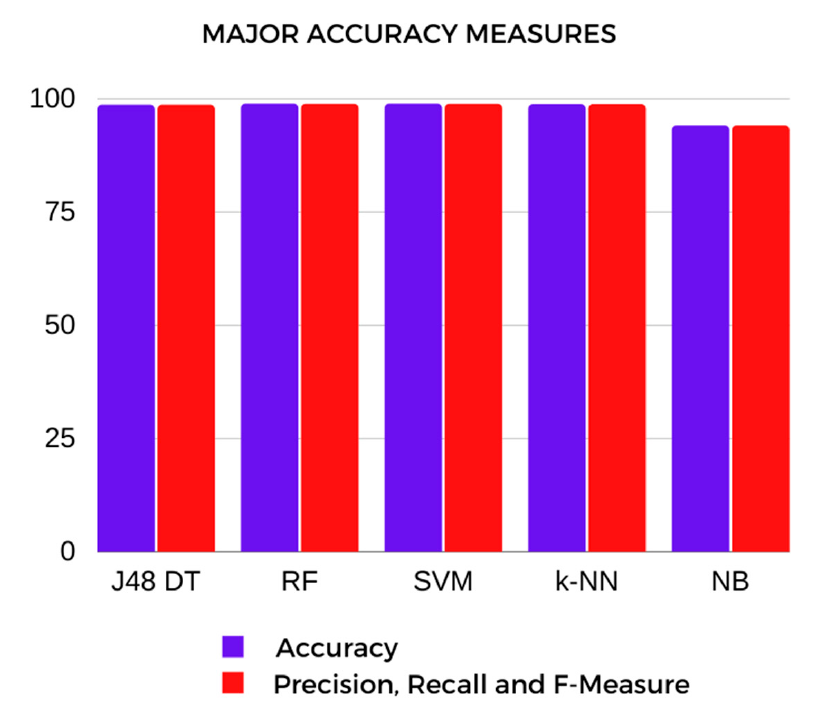
Figure 8. This figure shows the barchart of the results of the major accuracy measures of the developed model using each algorithm.